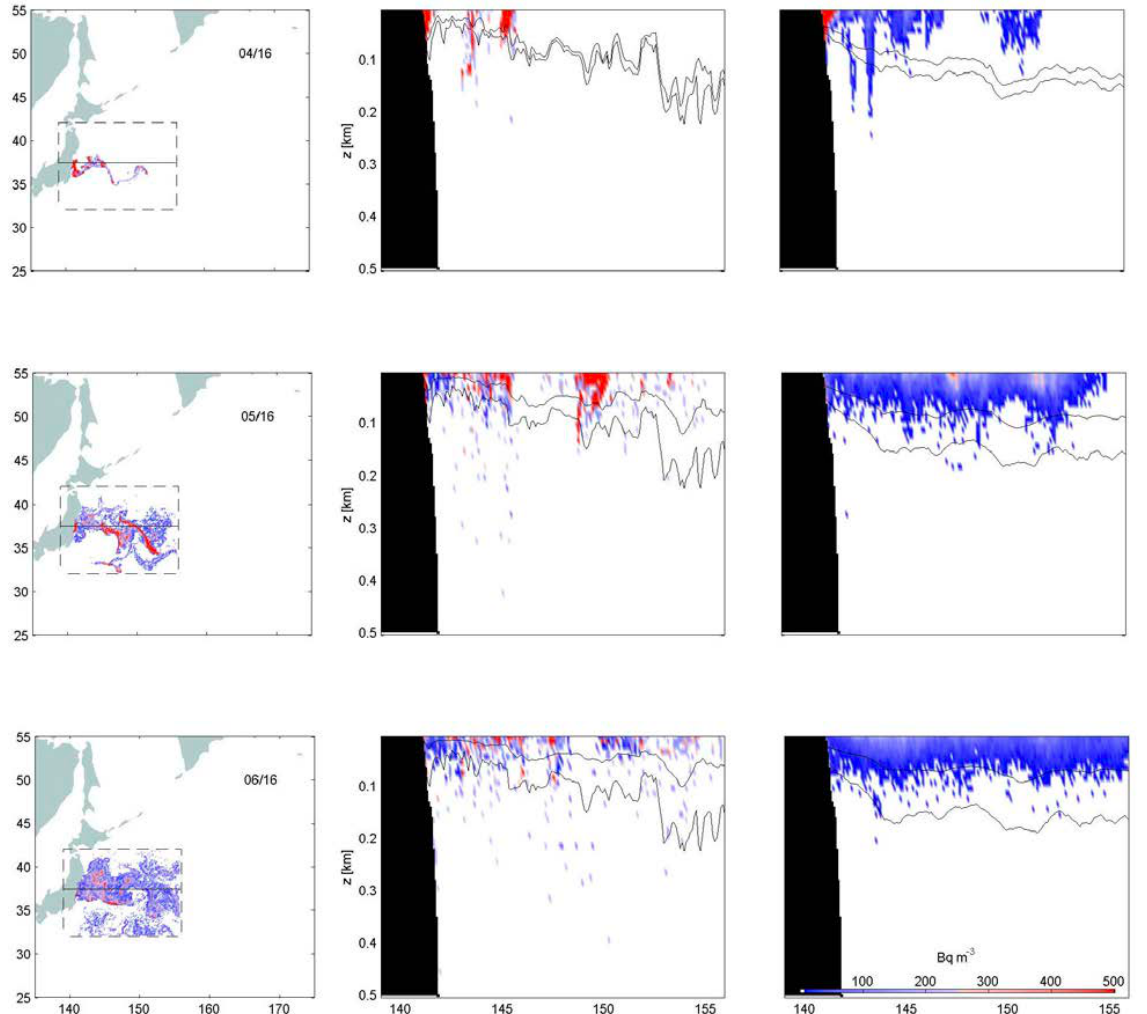
Fig. 9. NCOM-based model distributions of 137 Cs on select dates from the oceanic source. (left) Mixed-layer concentrations of 137 Cs. Dashed lines show the model domain. Source characteristics as in Fig. 5. (middle) Vertical slice of the 137 Cs field at the FNPP latitude (horizontal line in left panel). The mean and the deepest mixed-layer depth (km) computed from 18 May until the corresponding date are shown as gray contours. (right) Latitude-averaged over the domain concentration of 137 Cs. Latitude-averaged mean and deepest mixed-layer depth shown as gray contours.